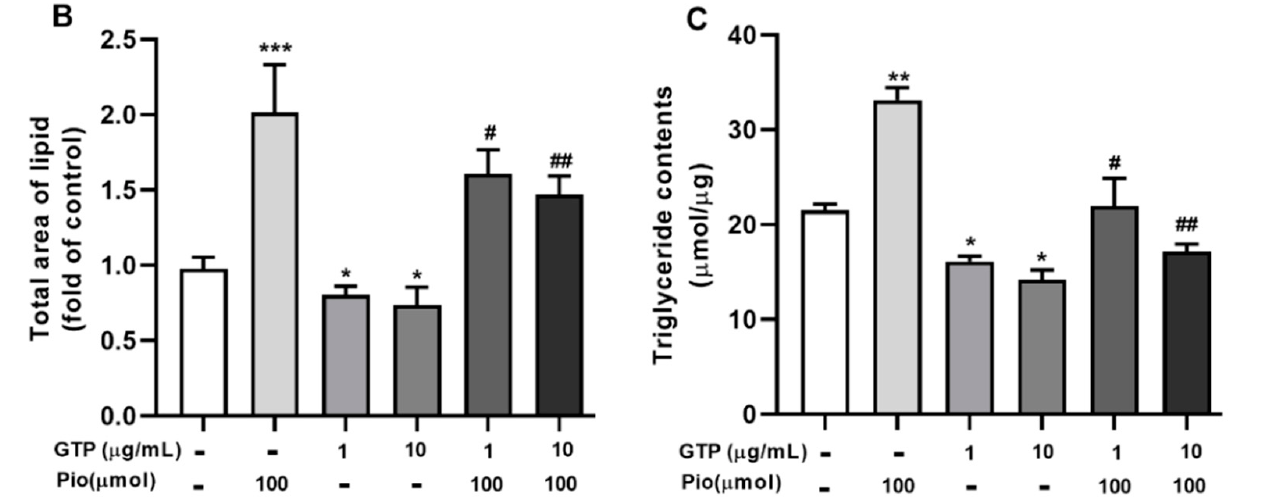
Figure 1. Green tea polyphenols (GTPs) decrease lipid accumulation and triglyceride synthesis during adipogenic differentiation of hADSC. ( A ). Image of the lipid droplets with Oil Red O (ORO) staining and examined by light microscopy at 100 × , objective magnification; ( B ). Quantitative data of the total area occupied by lipid droplets stained with ORO; ( C ). Triglyceride content was determined by measuring absorbance at 490 nm. Data are presented as means ± SE ( n = 5 per group). * p < 0.05, ** p < 0.01 and *** p < 0.001 GTPs and pioglitazone vs. the control; # p < 0.05 and ## p < 0.01 GTPs plus pioglitazone (Pio) vs. Pio